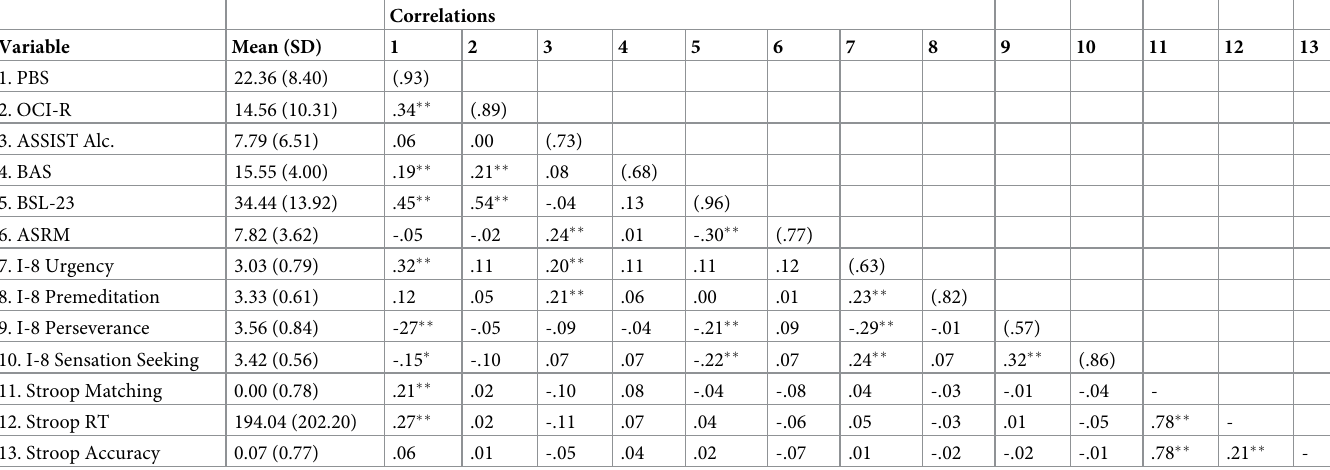
Table 1. Means, standard deviations, and correlations (Cronbach’s α estimate of internal consistency on the